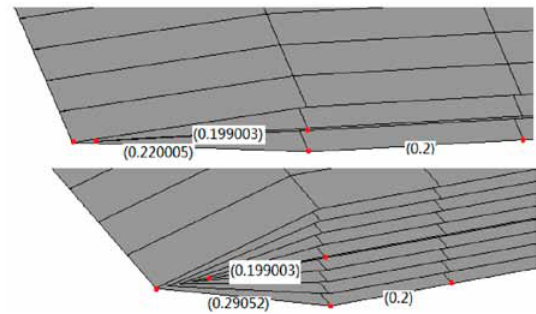
Fig. 1. Initial errors of flat direct folding